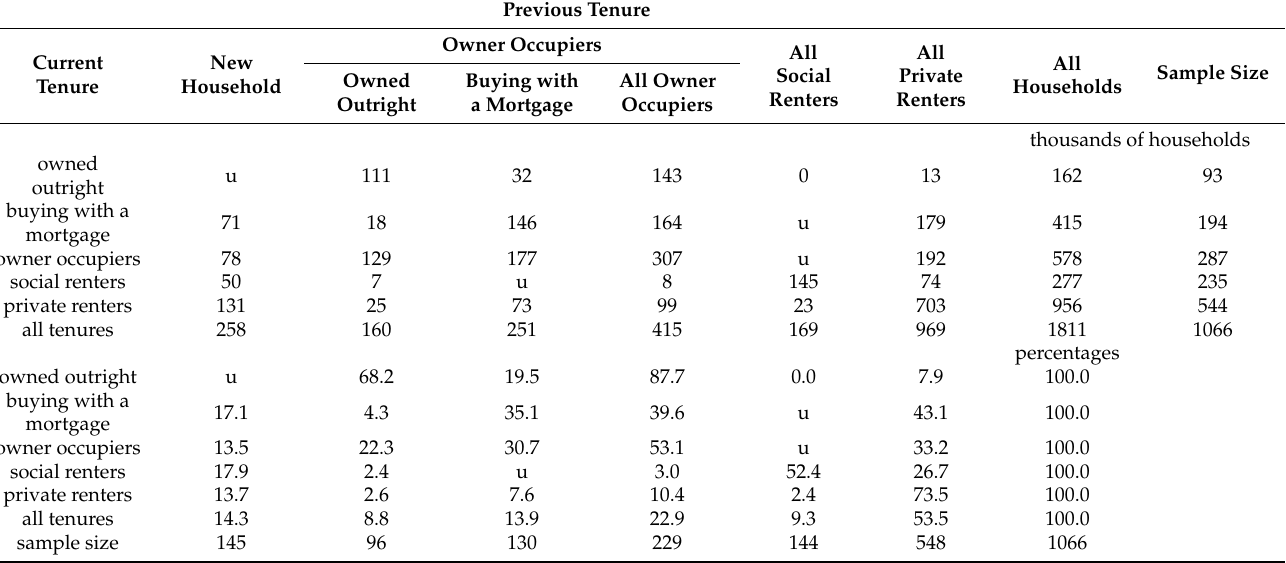
Table A17. Previous tenure by current tenure, 2019–2020 (u indicates that the sample size is too small to make a reliable